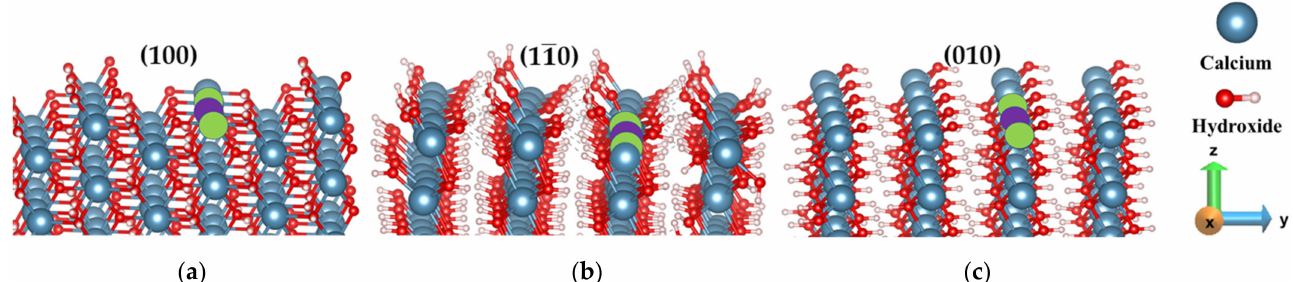
Figure 2. Dissolution scenarios of central Ca (violet) in absence of first and second nearest neighbors (green) removed one by one from: ( a ) (100), ( b ) (110) and ( c ) (010) facet of